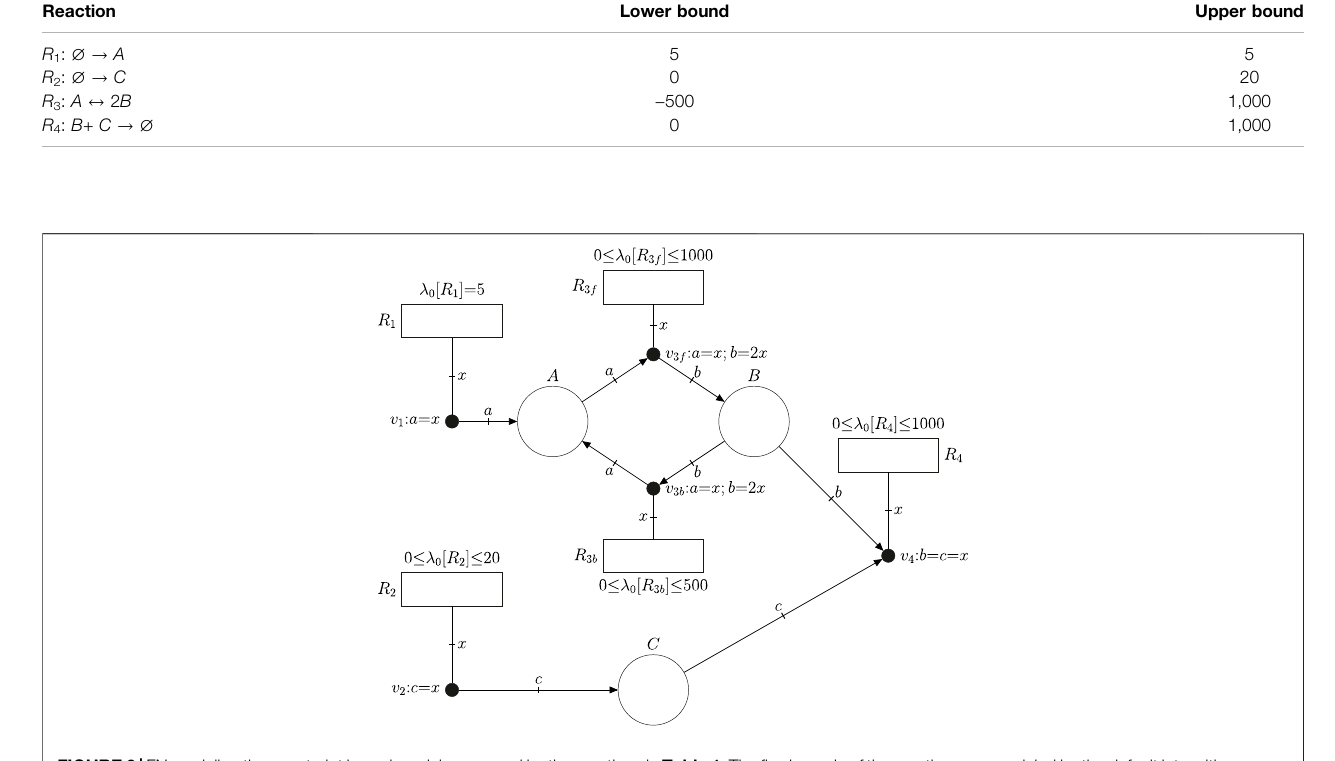
Frontiers in Molecular Biosciences |